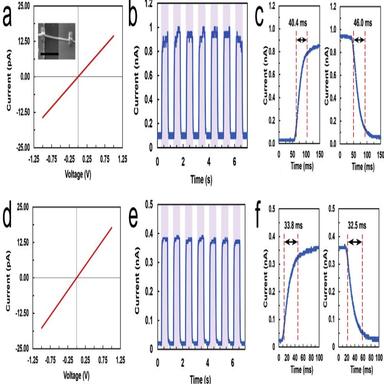
ZnOePbI2 single NW made using the thermal evaporation approach (a) dark state IeV characteristics, (b) onoff photoresponse, (c) time-resolved photoresponse measurements; and ZnOePbI2 single NW made by converting the lead oxide coating (d) dark state IeV characteristics, (e) onoff photoresponse, (f) time-resolved photoresponse measurements at 1 V bias voltage and 1 W/cm2 light intensity with 405 nm wavelength light. The inset shows an SEM image of a typical single-nanowire two-terminal photodetector. The sca